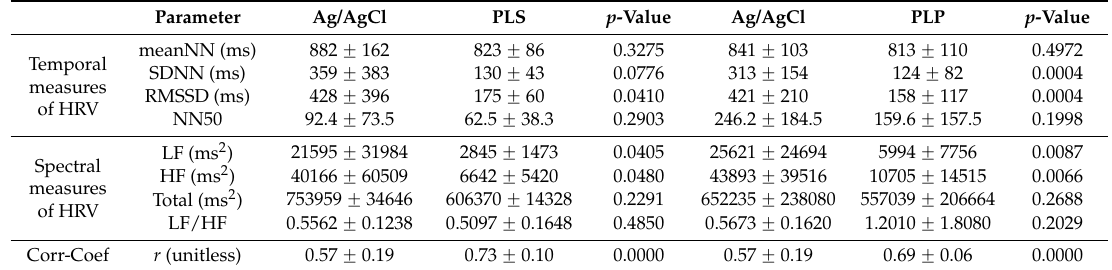
Table 6. Electrocardiogram signal quality—saltwater immersion without movement condition.